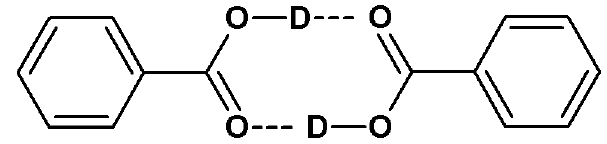
Figure 5. Deuterium-bonded dimers of benzoic acid.